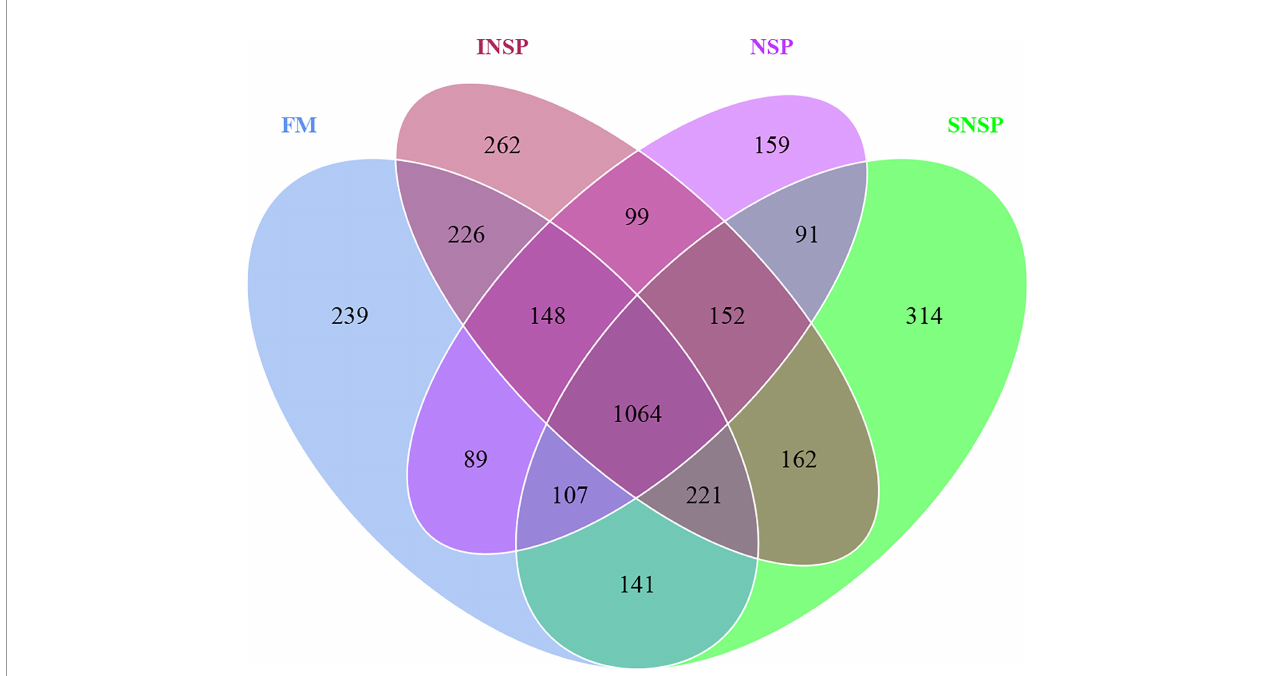
FIGURE 2 | Venn diagram of OTUs in each group. Venn graph was drawn by analyzing the common and unique OTUs among different groups according to the results of OTU clustered analysis with 97% identi fi cation based on 16S rRNA sequencing